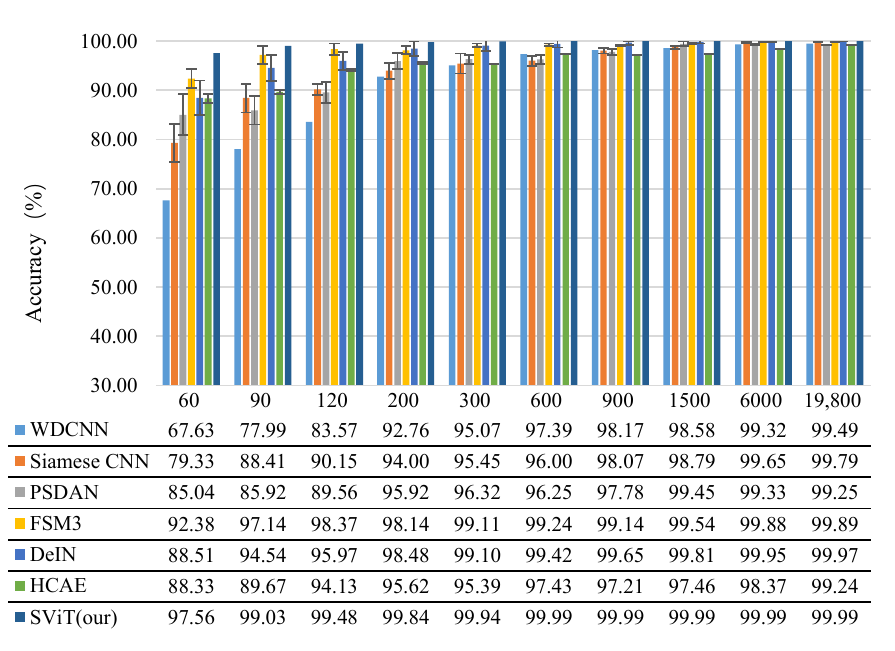
Figure 10. Diagnosis results of the proposed method compared with those of the comparison models.